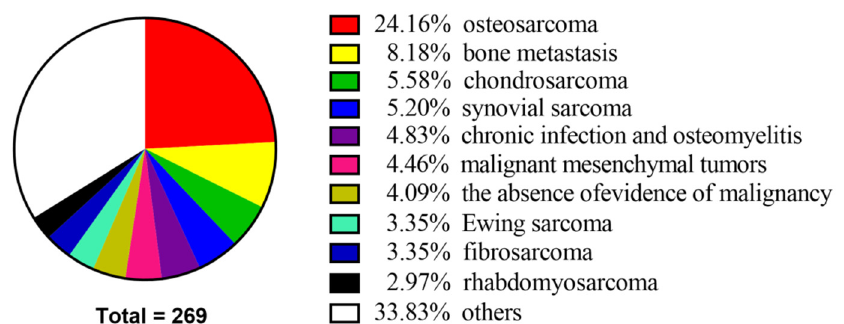
Figure 1. The ten leading causes of MDT patient discussion. Table 1. Demographic data of patients discussed by the MDT during each year of the study.